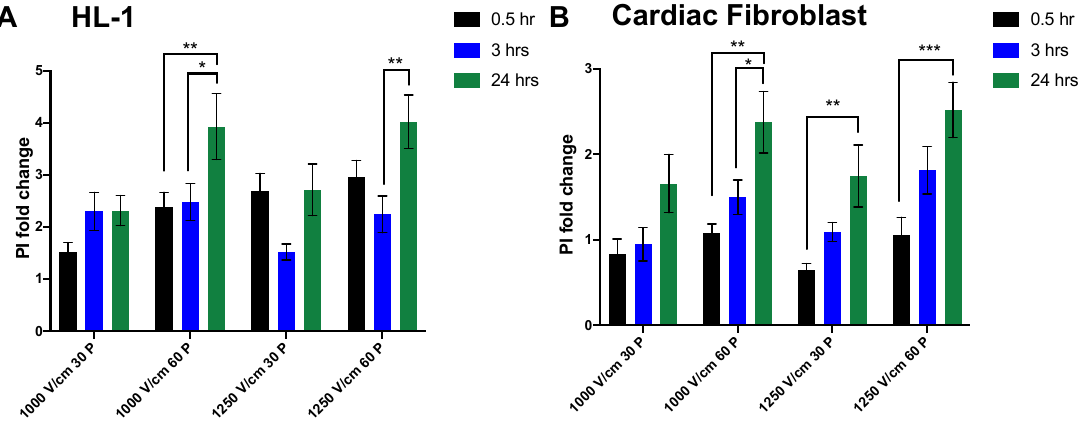
Figure 6. Temporal dynamics of cardiac cells in response to electroporation. The evolution of membrane permeability to PI were significantly decreased after 24 h at high voltage of 1250 V/cm in Hl-1 cardiomyocytes ( A ). In cardiac fibroblasts, in contrast, the PI + fold change increased after 24 h ( B ). All data shown as mean ± SEM. Statistical significance performed using two-way ANOVA (* p < 0.05, ** p < 0.005, *** p < 0.001,). Table 2. Direct comparison of PI permeability between Hl-1 cardiomyocytes and cardiac fibroblasts at the 0.5-hour time point.